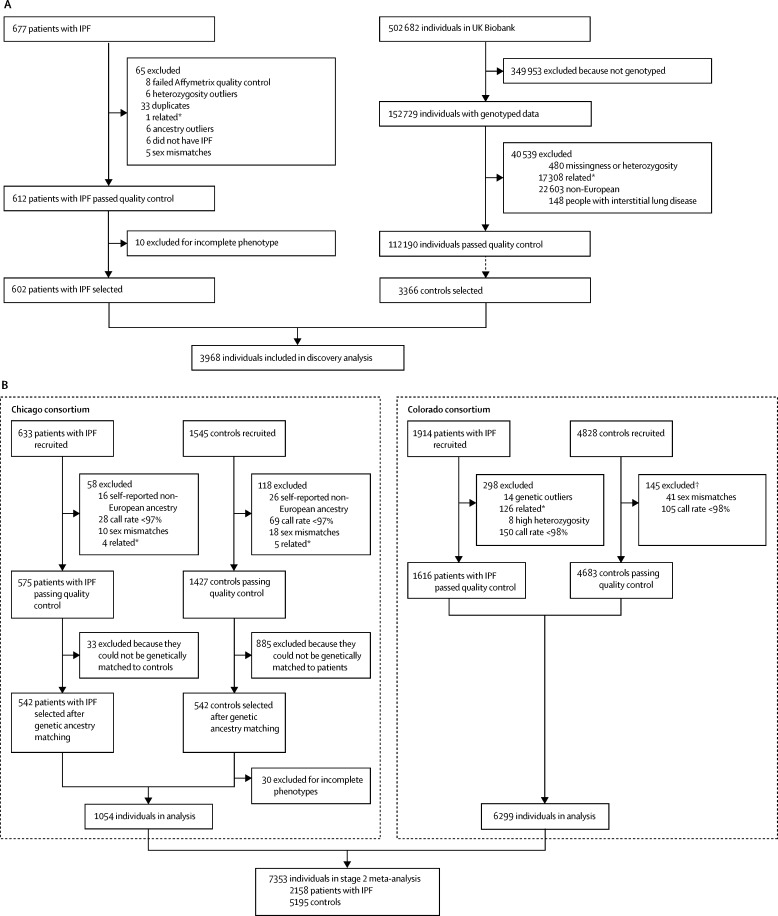
Quality control and sample selection flow chart(A) Stage 1 genome-wide association study. (B) Stage 2 follow-up analyses. *On identification of a pair of individuals who were second-degree relatives or closer, one individual was excluded. IPF=idiopathic pulmonary fibrosis. †One patient had both call rate <98% and sex mismatch.